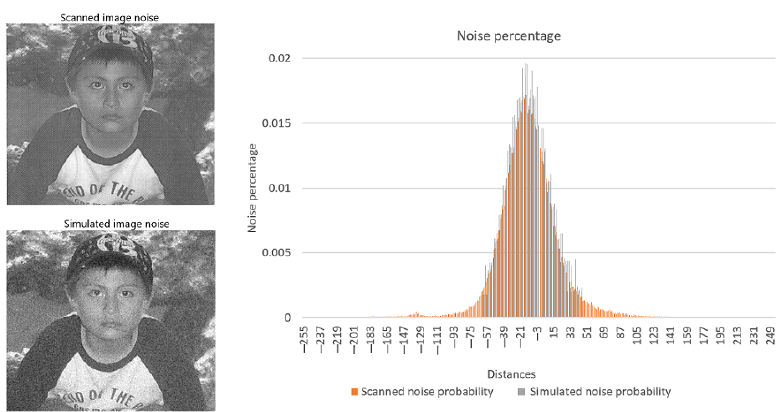
Figure 15. Scanned image vs simulated image noise